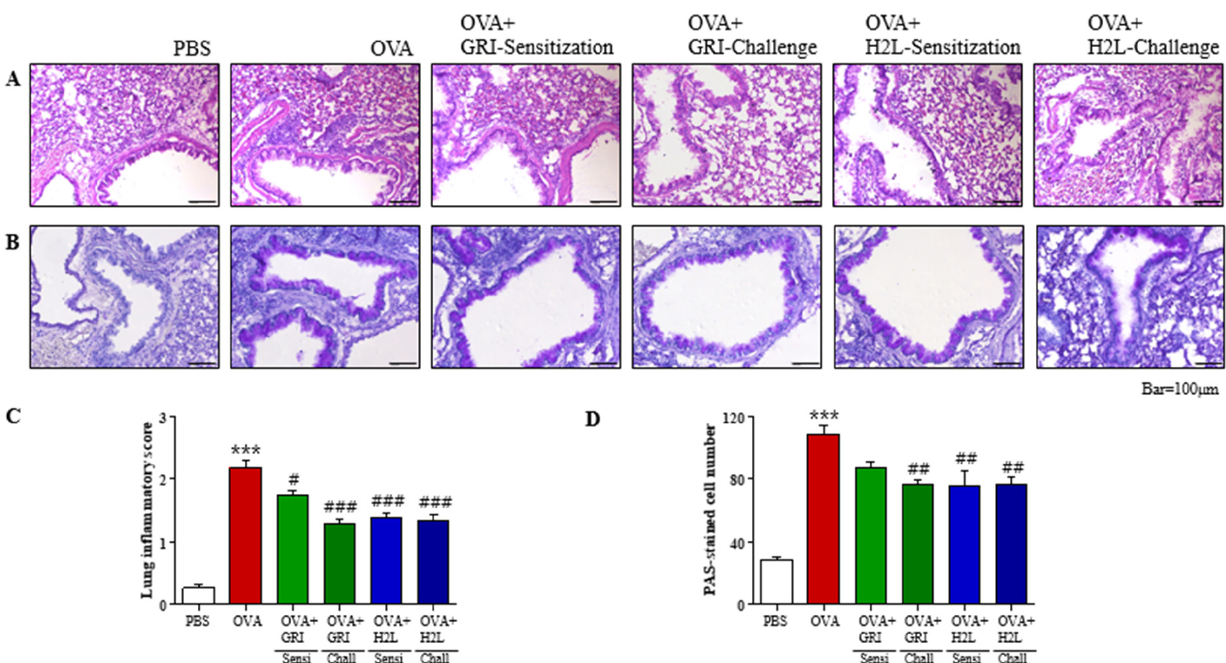
Figure 4. H2L5186303 and GRI977143 protect against airway inflammation and mucin production. ( A ) Panels show H&E ‐ stained sections of lung tissues from the phosphate ‐ buffered saline (PBS), ovalbumin (OVA), H2L5186303 ‐ treated OVA (before sensitization or challenge), and GRI977143 ‐ treated OVA groups (before sensitization or challenge). Small dark blue dots around the bronchioles indicate eosinophils, which were scarce in the PBS but densely accumulated around the bronchioles in the OVA group. However, eosinophil accumulation was less obvious in the OVA + H2L5186303 and GRI977143 groups than in the OVA group. ( B ) Panels show PAS/hematoxylin ‐ stained sections of lung tissues from the PBS, OVA, H2L5186303 ‐ treated OVA (before sensitization or challenge), and GRI977143 ‐ treated OVA groups (before sensitization or challenge). PAS staining showed that mucin was stained purple. A darker and denser purple color surrounding the bronchioles was ob ‐ served in the OVA group but not in the PBS group. ( C ) Lung inflammation was semi ‐ quantitatively evaluated, and histological findings were scored as described in the Materials and Methods section. ( D ) Mucous production was measured by counting the number of PAS ‐ positive cells per millimeter of bronchiole ( n = 5 per group). Values represent mean ± standard error (SE) ( n = 5). *** p < 0.001 vs. the PBS ‐ treated group, # p < 0.05, ## p < 0.01, ### p < 0.001 vs. the OVA ‐ treated group. 2.5. GRI977143 and H2L5186303 Suppressed the Production of Th2 and Th1 Cytokines in the BALF and Lungs Th2 cells contribute to the pathogenesis of allergic asthma by producing Th2 cyto ‐ kines, such as IL ‐ 4, IL ‐ 5, and IL ‐ 13, leading to eosinophil accumulation in the airway wall, mucus overproduction, and IgE synthesis. In addition, Th1 and Th17 cytokines are in ‐ volved in late ‐ stage pathogenesis of asthma. Therefore, changes in the mRNA levels of the Th2 cytokines IL ‐ 4 and IL ‐ 13, and Th1 cytokine IFN ‐γ were measured by qPCR in BALF